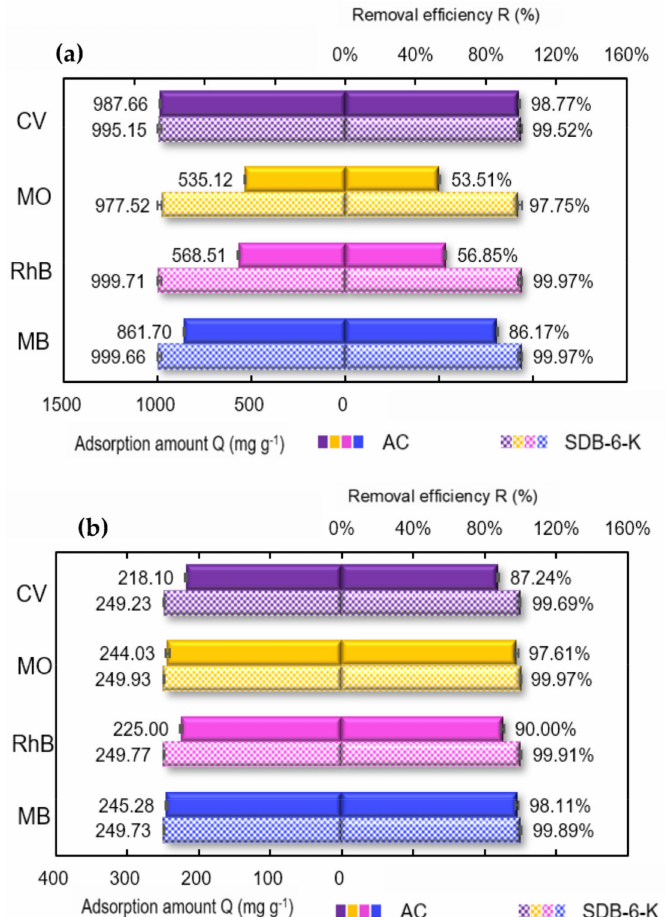
Figure 8. ( a ) Adsorption of different single dyes by SDB-6-K and AC; ( b ) adsorption of mixture dyes by SDB-6-K and AC. Conditions: ( a ) 1000 mg L − 1 CV/MO/RhB/MB; ( b ) MB+RhB+MO+CV, each is 250 mg L − 1 ; T = 298 K; m = 0.025 g; V = 25 mL; t = 2 h. SDB-6-K and AC. Conditions: ( a ) 1000 mg L −